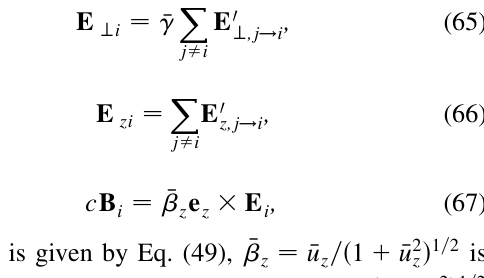
T (cid:1) 4 MeV , radius a (cid:1) 6 (cid:4) m , half-length B (cid:1) 100 nm and averaged 0 and (b) longitudinal RMS momentum spread (cid:1) u as x z